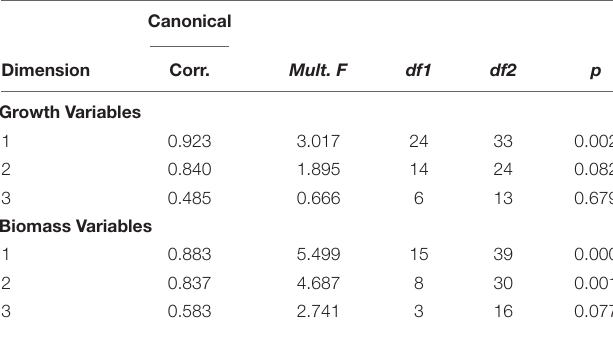
TABLE 3 | Tests of Canonical Dimensions for environmental and growth and biomass